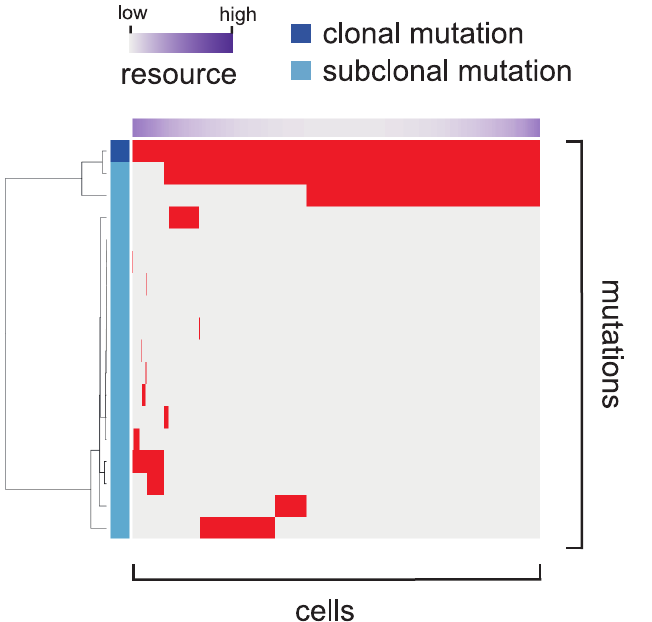
Fig 3. Visualization of the mutation profile matrix. From a simulated tumor, we randomly sampled 1000 cells and their mutation profile is presented as a mutation profile matrix. Columns corresponding to cells were ordered based on the original cell positions and rows corresponding to mutation were reordered by hierarchical clustering. We attached colored bands indicating mutation types and the distribution of the resources on the left and top of the heat map, respectively. For mutation type, we define mutations whose frequency is more than 0.95 as clonal mutations and the others as subclonal mutations.